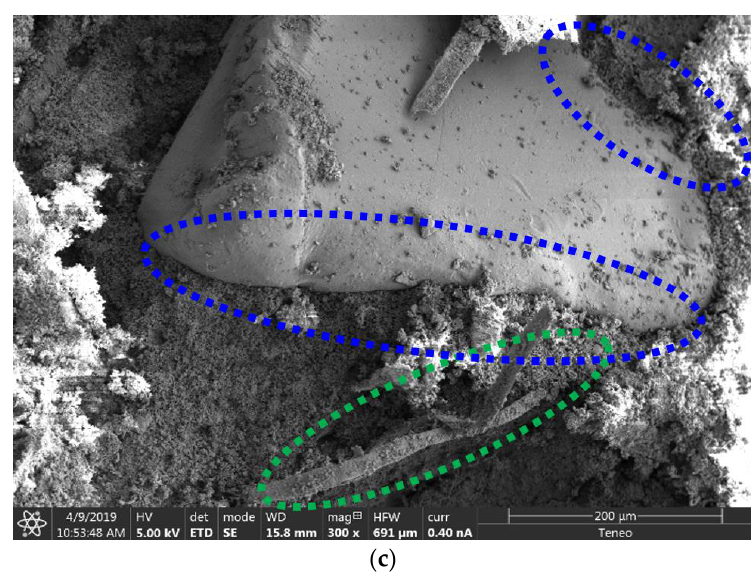
Figure 8. SEM images of the gypsum plasters (300×): ( a ) P20; ( b ) GPW50-P20; ( c ) GPW100-P20. Highlights: crystalline gypsum structure (red); good adherence between the PC and the gypsum matrix (blue); glass fiber (green) and bad adherence between the matrix and the plastic aggregate (purple).